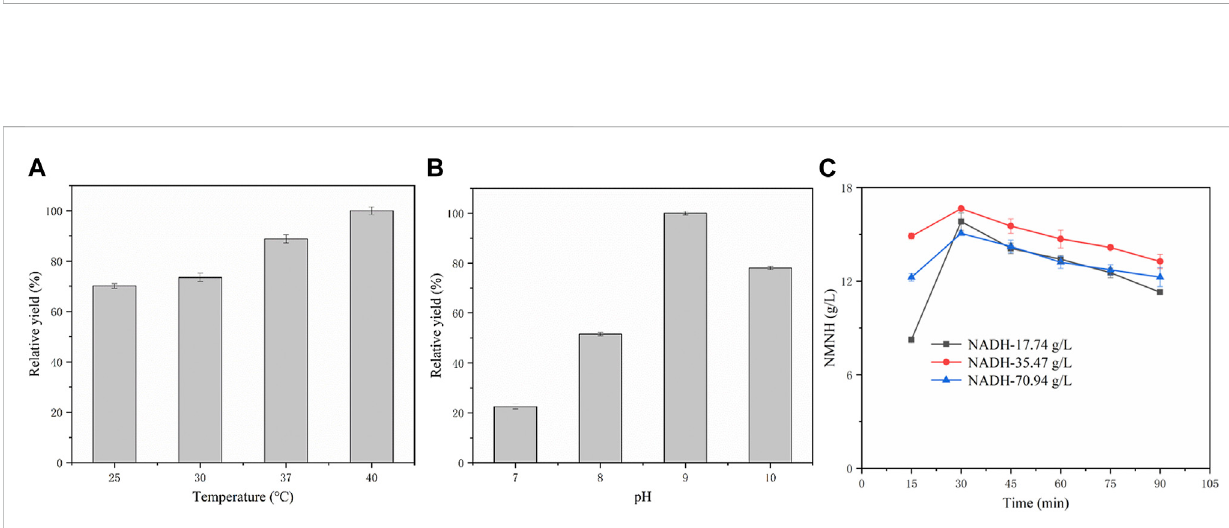
Frontiers in Bioengineering and